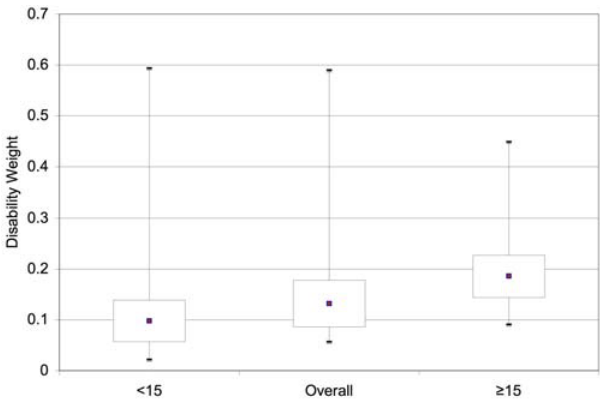
Figure 4. Probabilistic sensitivity analyses. Boxplots depicting the results of 5,000 simulation Monte Carlo analysis for each age-group model. Boxes represent the median, 25 th and 75 th percentiles, and error bars extend to the 2.5 th and 97.5 th percentile. Means are depicted by the